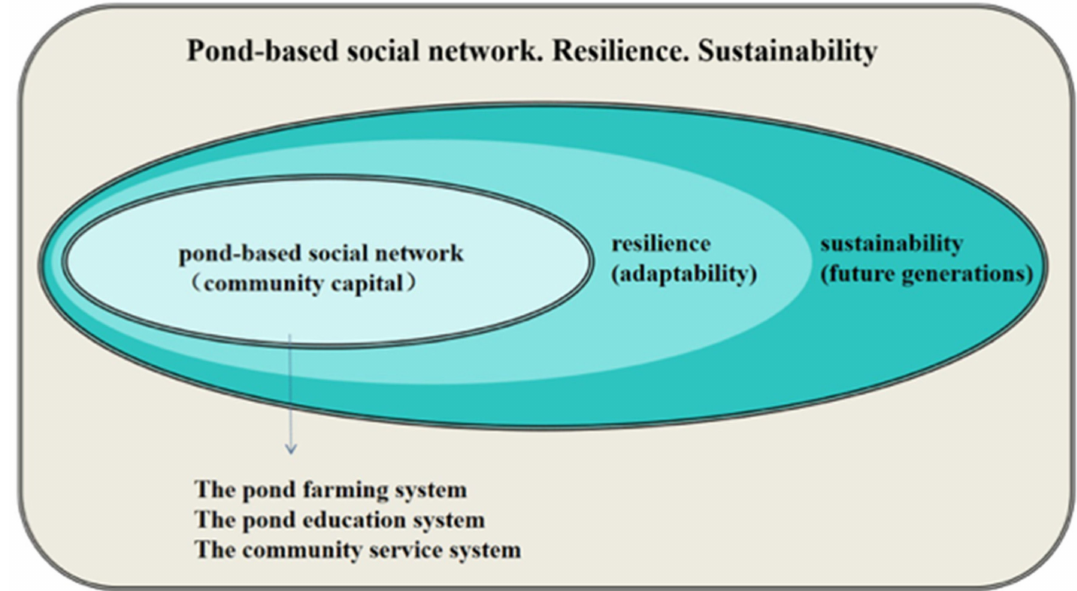
Figure 6. Relationship of community resilience with the pond-based social